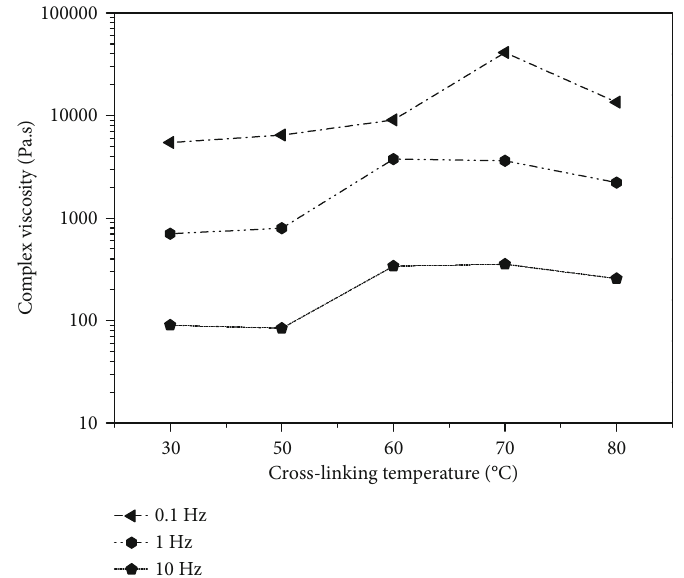
Figure 12: Dependency of complex viscosity on curing temperature for the H5 samples di ff erently cross-linked at certain frequencies after one hour of